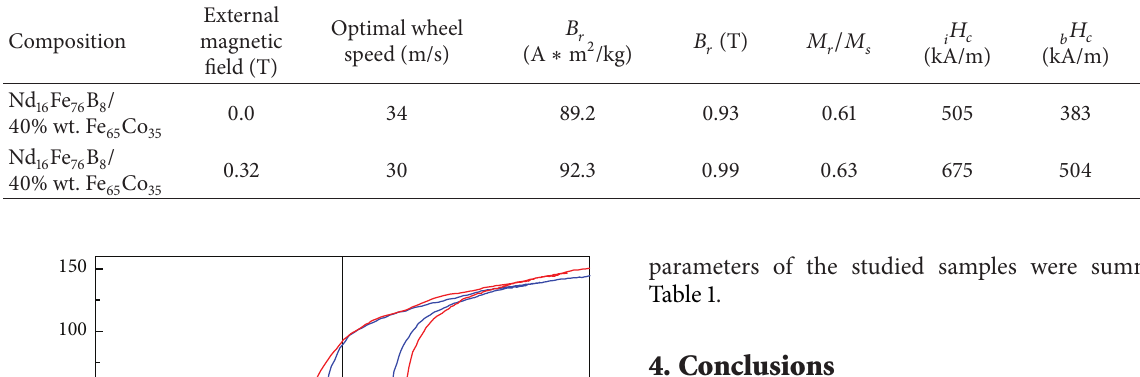
Table 1: The summary of parameters of samples: the samples are the powdered ribbons, the self-demagnetization factor 𝐷 = 0.33 , and the mass density 𝜌 = 7.6 g/cm 3 .